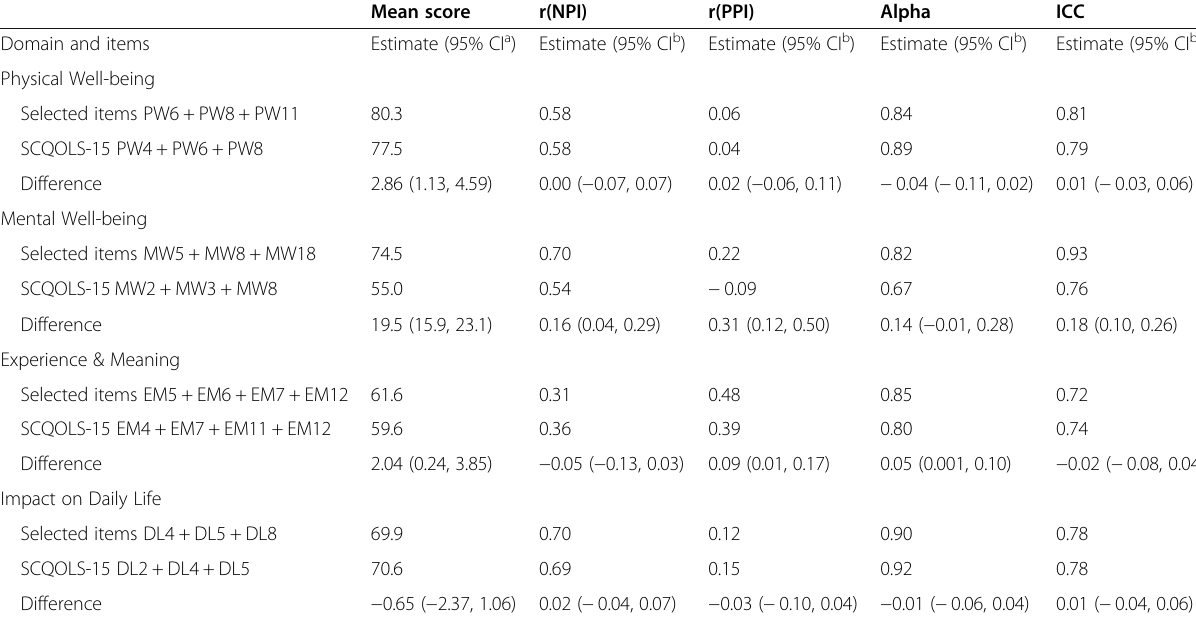
Table 4 Comparison of mean score and measurement properties between the selected items and the items in the 15-item short form of the Singapore Caregiver Quality of Life Scale (SCQOLS-15) developed in a previous study of caregivers of cancer patients